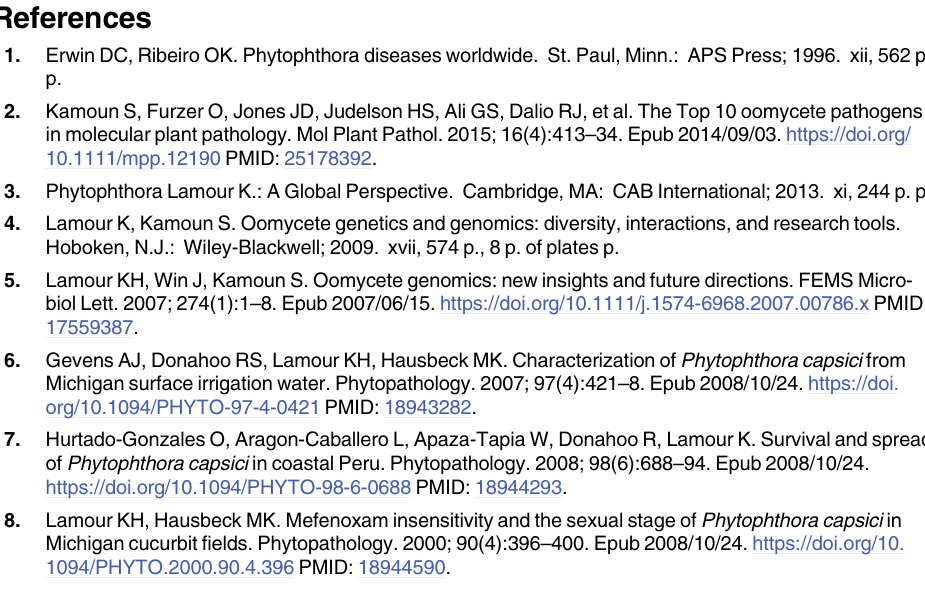
S2 Fig. Sequence coverage density plots for 33 isolates of Phytophthora capsici or near rela- tives. (PDF) S3 Fig. Sequence coverage of a parent and four single zoospore progenies for the 10 largest linkage groups of Phytophthora capsici . S4 Fig. Allele frequency histograms for parent and 4 zoospore progeny of Phytophthora capsici for linkage groups 1 to 10. S1 Table. Summary data for additional sequenced Phytophthora capsici or close relatives.